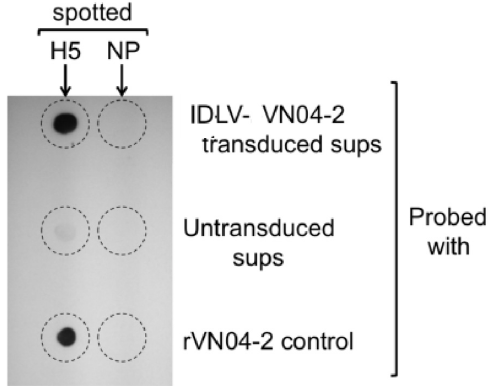
Figure 3. VN04-2 mAbs generated from integrase-defective lentiviral vectors (IDLV) bind H5 HA. Supernatants (sups) from cells transduced with IDLV-VN04-2 were used to probe dried nitrocellulose dot plots spotted with recombinant IAV H5 HA protein, or NP as specificity control. Recombinant VN04-2 mAbs (rVN04-2) were used as a positive control for detection of H5 HA. Supernatants from untransduced cells were used as a negative control.